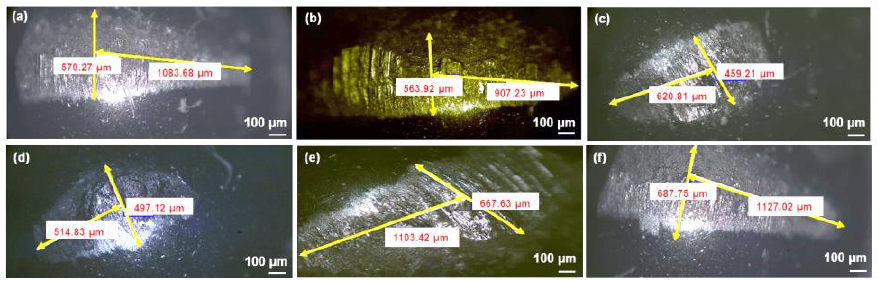
Figure 6. Typical SEM images and EDS mapping for the wear tracks of ( a ) Pure Al ( b ) Al-0.25% wt% GO ( c ) Al-10 Vol% Al 2 O 3 ( d ) Al-10 Vol% Al 2 O 3 -0.25 wt% GO ( e ) Al-10 Vol% Al 2 O 3 -0.5 wt% GO ( f ) Al-10 Vol% Al 2 O 3 -1 wt% GO, after the wear test at a load of 3 N, sliding speed of 0.1 m/s, and a sliding distance of 100 m.